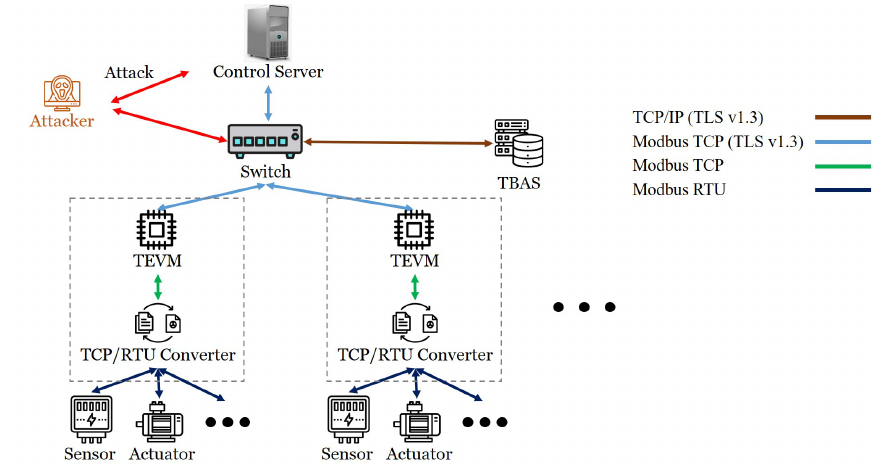
Figure 2. The proposed